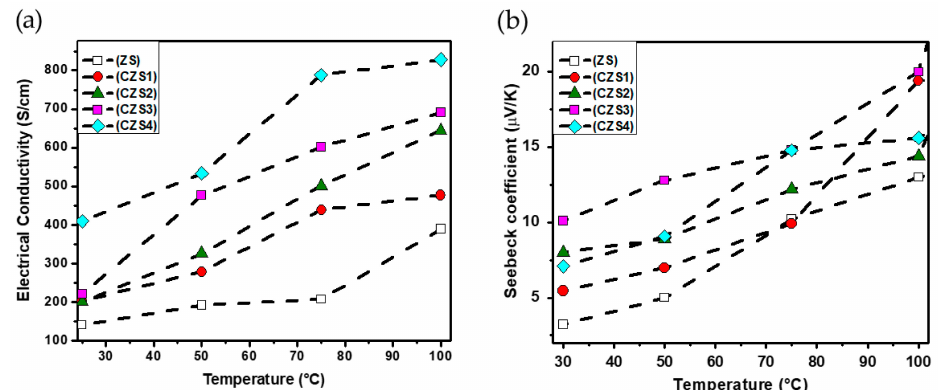
Figure 1. Measured Measured values of the electrical conductivity ( a ) and of Seebeck coefficient ( b ) for the undoped and Cu-doped ZnSe samples, as a function of